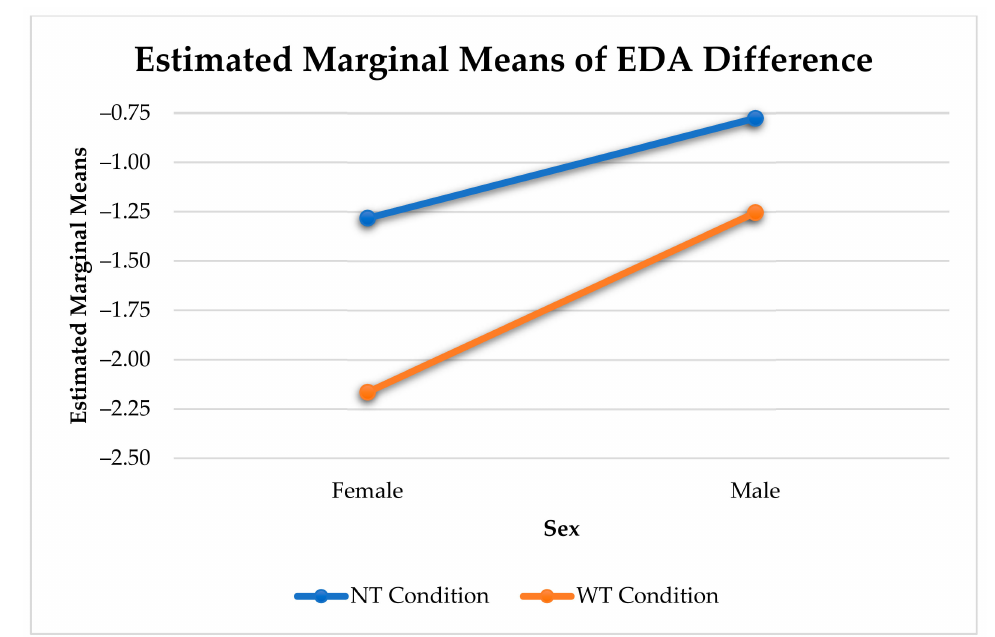
Figure 10. Sex Differences in Physiological Arousal Change Elicited by Utterances with or Without Affective Touches.